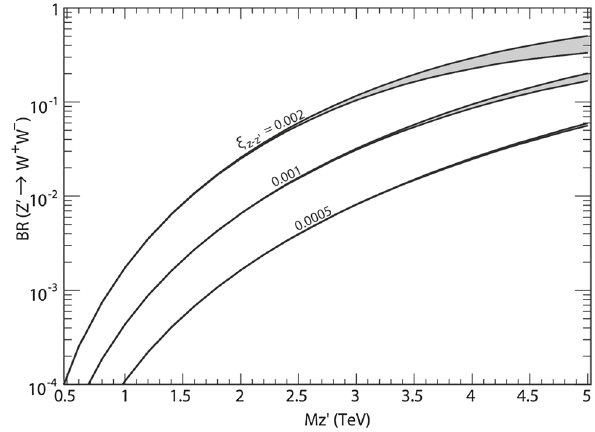
Fig. 2 Branching fraction BR ( Z (cid:2) → W + W − ) vs. M Z (cid:2) in the EGM fornon-zero Z – Z (cid:2) mixingfactor ξ Z − Z (cid:2) = 2 · 10 − 3 , 1 · 10 − 3 and5 · 10 − 4 . The shaded bands represent the uncertainty resulting from the inclusion of the Z H decay mode to the total decay width (cid:11) Z (cid:2) , the upper and lower bounds correspond to the assumptions (cid:11) ZH